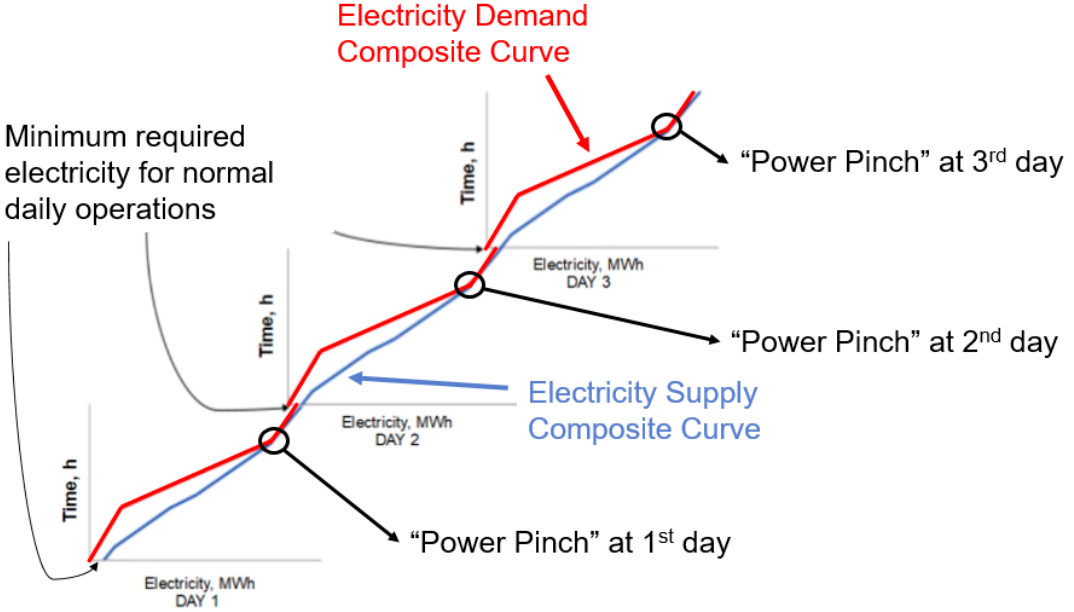
Figure 11. Illustration of Power Pinch Analysis (PoPA), adapted from Wan Alwi et al.